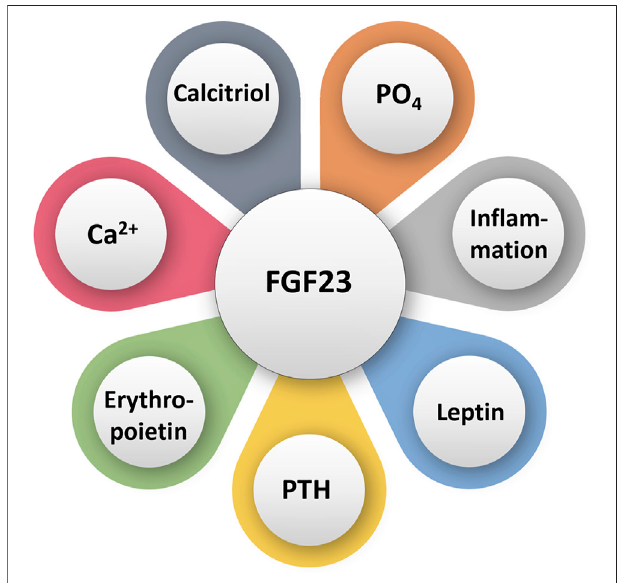
FIGURE 1 | Simpli fi ed diagram illustrating various factors that can directly or indirectly in fl uence FGF23 activities. PO 4 : phosphate; Ca 2+ :